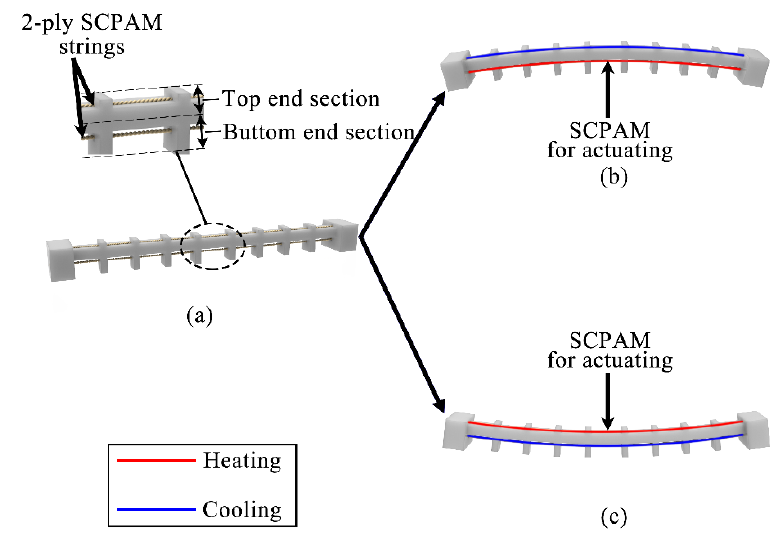
Figure 2. Definitions of forward bending and backward bending for the module. Red line means the power is on, and blue line means the power is off for the SCPAM strings. ( a ) The initial state of the soft robot module, as well as the definitions of the top and bottom end sections of the module. ( b ) Forward bending mode. ( c ) Backward bending mode.